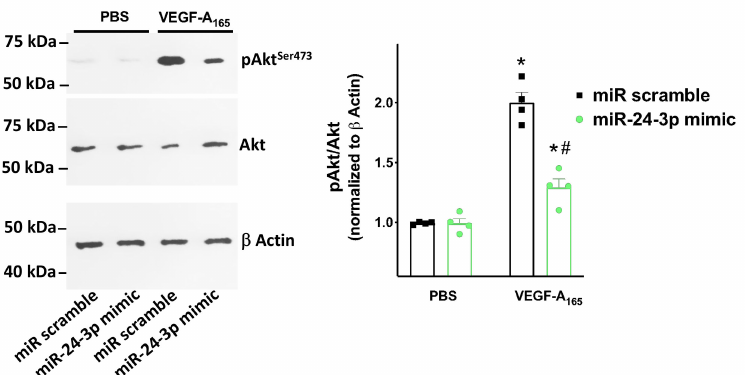
Figure 5. Targeting Neuropilin-1 by miR-24 significantly reduces Akt activation. Akt phosphory- lation in Ser 473 (representative immunoblots from 4 experimental assays) triggered by VEGF-A 165 (50 ng/mL) was measured in hBMECs transfected with miR-24-3p mimic or miR scramble * p < 0.05 vs. PBS, # p < 0.05 vs. miR-scramble. PBS: Phosphate-buffered